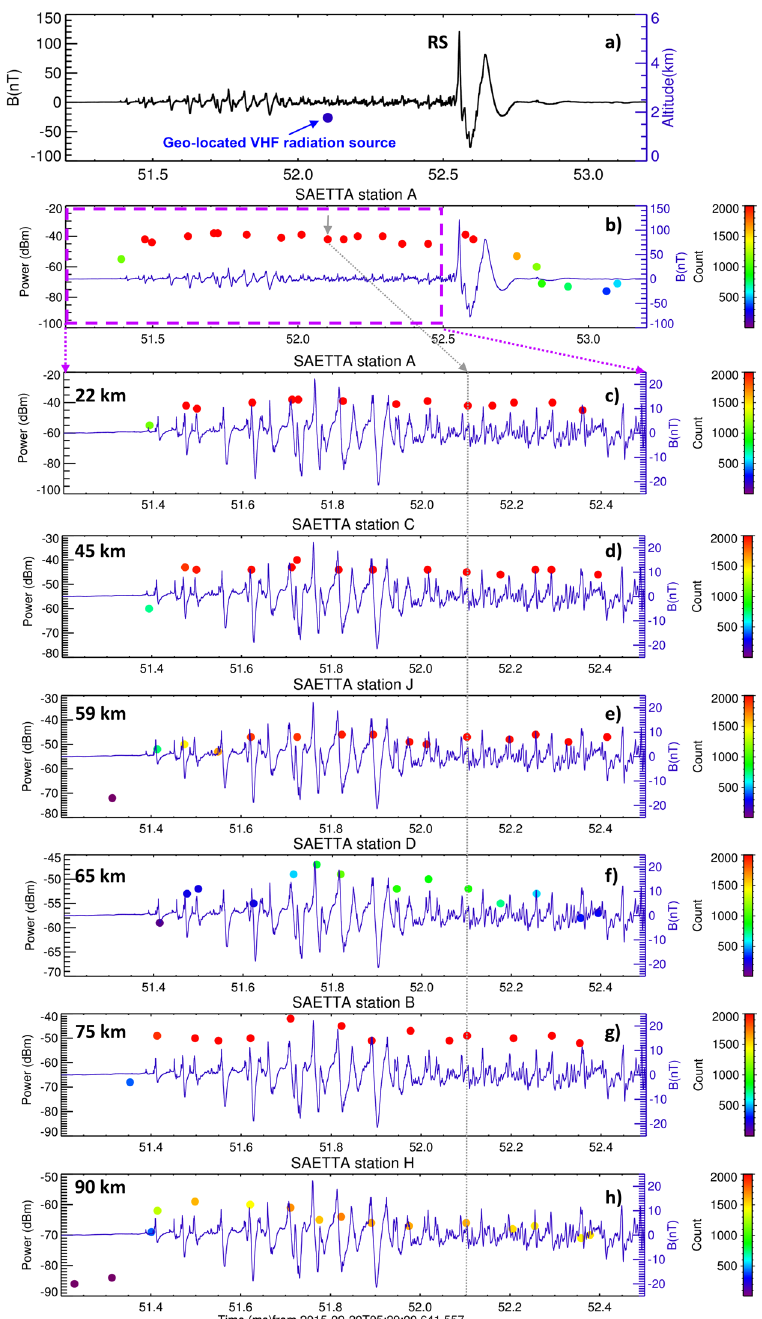
Figure 3. Example of a negative cloud-to-ground discharge from the 2015 dataset. A continuous BLESKA waveform showing a sequence of PBPs and the corresponding return stroke pulse (20 September 2015, 05:29:00.7 UTC, 9.45°E, 42.80°N) from the group X (see text) with ( a ), geo-located VHF radiation sources including their occurence altitudes from the SAETTA LMA and ( b ), peaks of radiated VHF power recorded at the closest SAETTA station A. The abscissas and color-coding are the same as in Fig. 2. ( c–h ) 1.3 ms-long detailed plots showing the PB pulse sequence with the peaks of radiated VHF power detected at different stations (A, C, J, D, B, and H). Gray arrow and line show the only one geo-located VHF radiation source occurring within the pre-stroke period of the observed